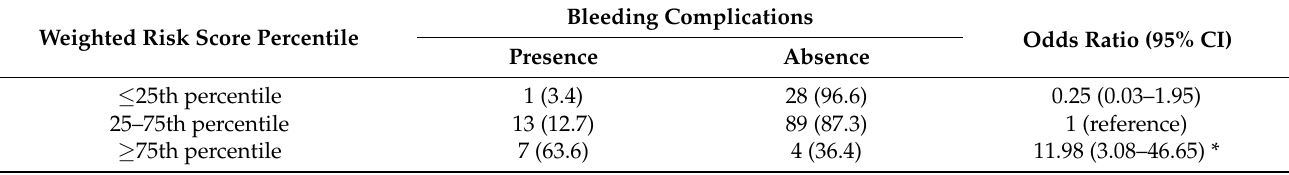
Table 4. Weighted risk score analysis of patients with bleeding